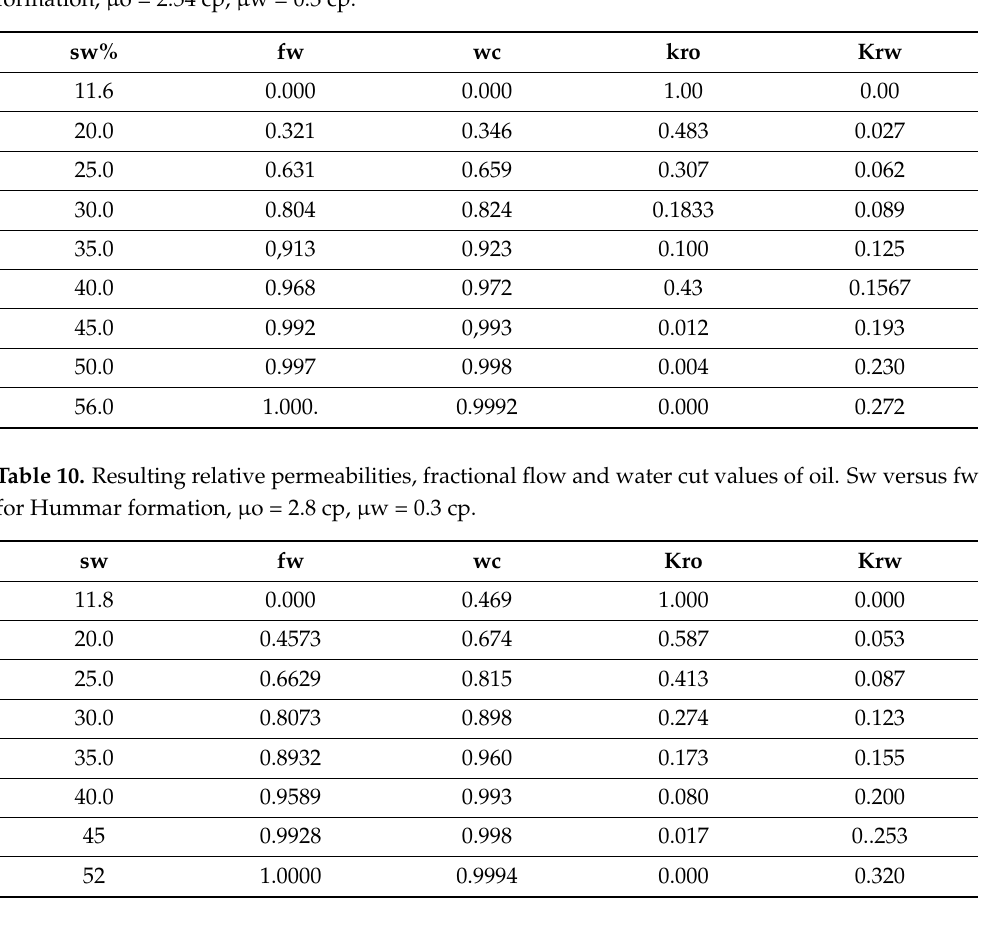
Table 9. Resulting relative permeabilities, fractional flow data of oil. sw versus fw for Shueib formation, µ o = 2.54 cp, µ w = 0.3 cp.